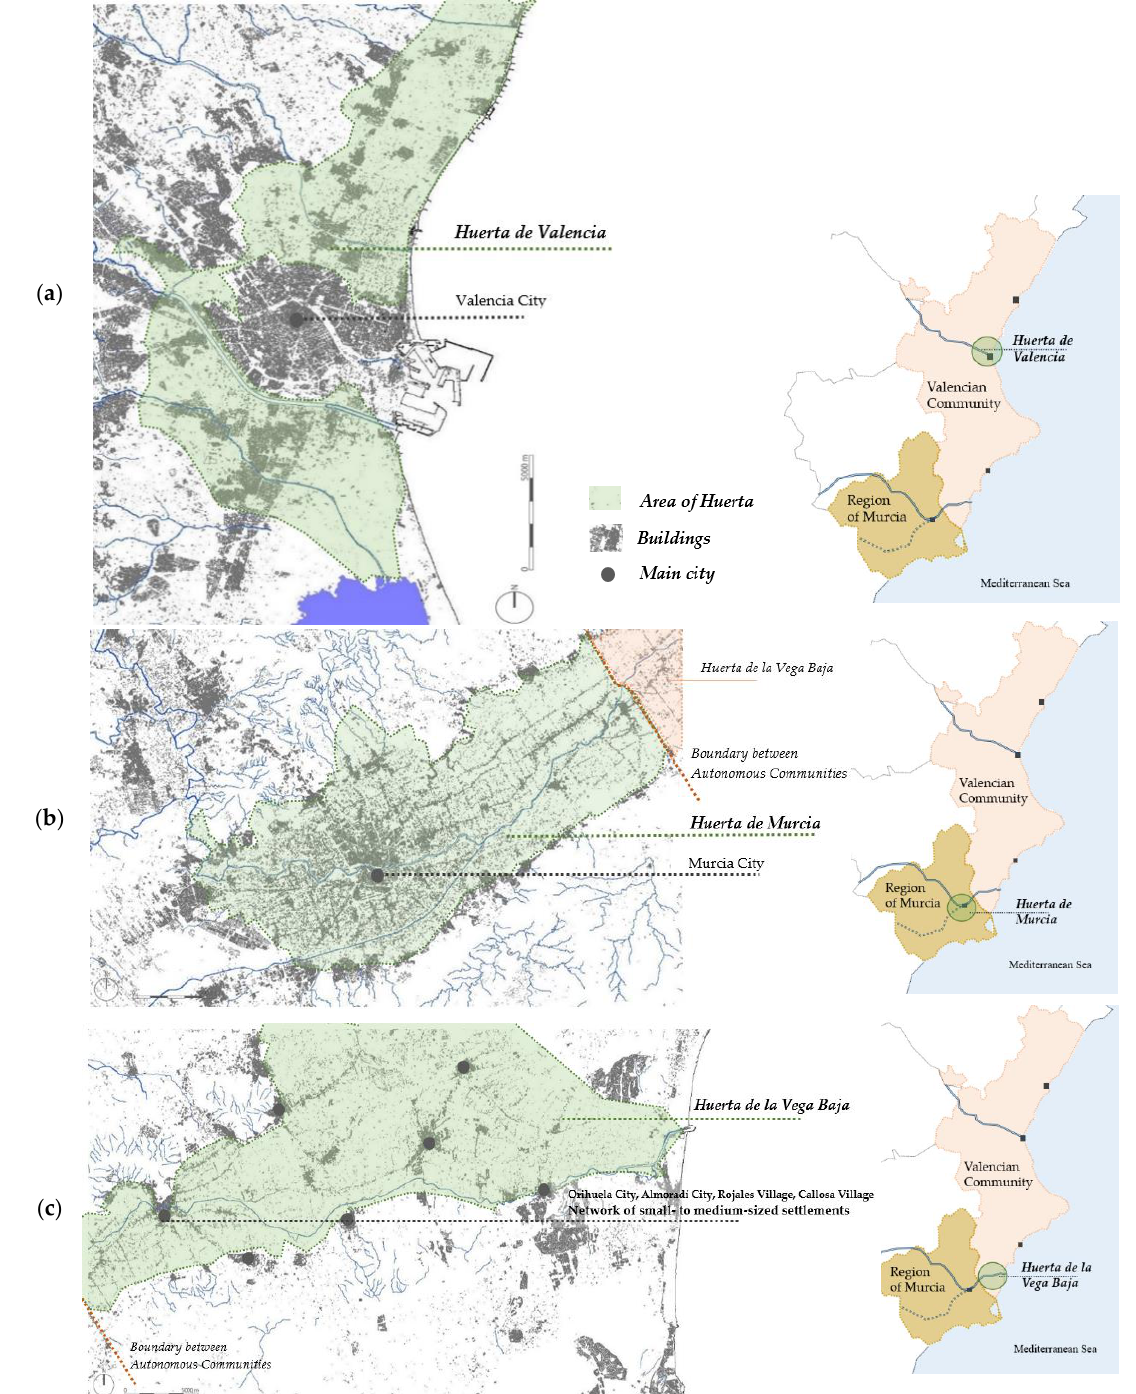
Figure 6. Settlement network and land occupation in the three Huertas territories. ( a ) Huerta de Valencia . ( b ) Huerta de Murcia . ( c ) Huerta de la Vega Baja . Source: Adapted from the National Geographic Institute of Spain [29].